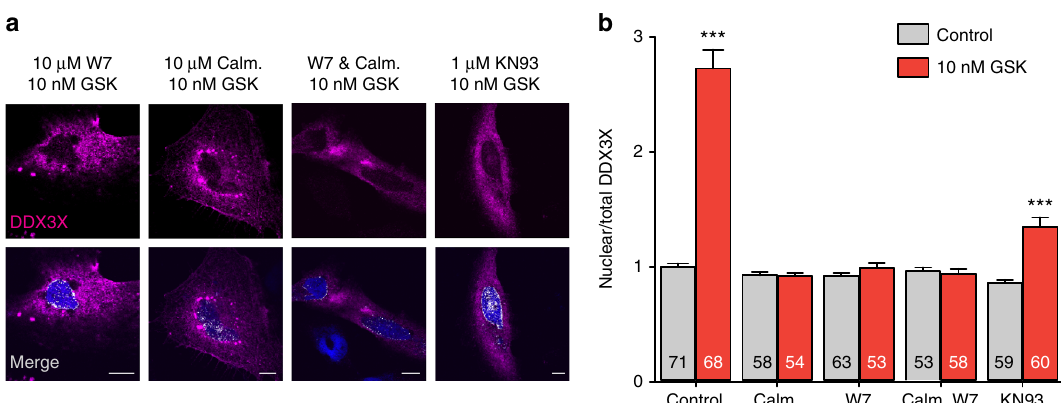
Fig. 4 Calmodulin- and calmodulin kinase II-dependent nuclear accumulation of DDX3X. a Confocal immuno fl uorescence images of DDX3X (magenta) in HeLa cells overexpressing TRPV4-V5 and DDX3X-Myc. Nuclei were stained with DAPI (blue). Colocalization of DDX3X and nuclei is shown in white in the merge panels. b Mean± SEM nuclear/total DDX3X ratio determined under the experimental conditions indicated. The number of cells analyzed for each condition is indicated in each bar. The data are means ± SEM. *** P < 0.001 when comparing isotonic control with any other condition as determined by non- parametric Krustal – Wallis followed by Dunn ’ s post hoc test. Scale bar = 10 μ